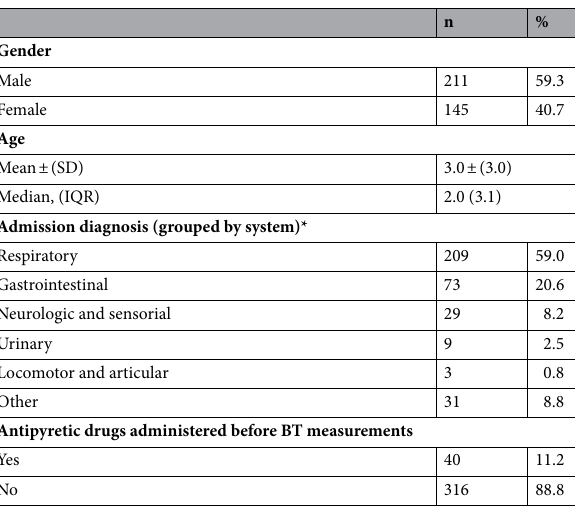
Table 1. Participants’ characteristics (n = 356). *Missing data n =